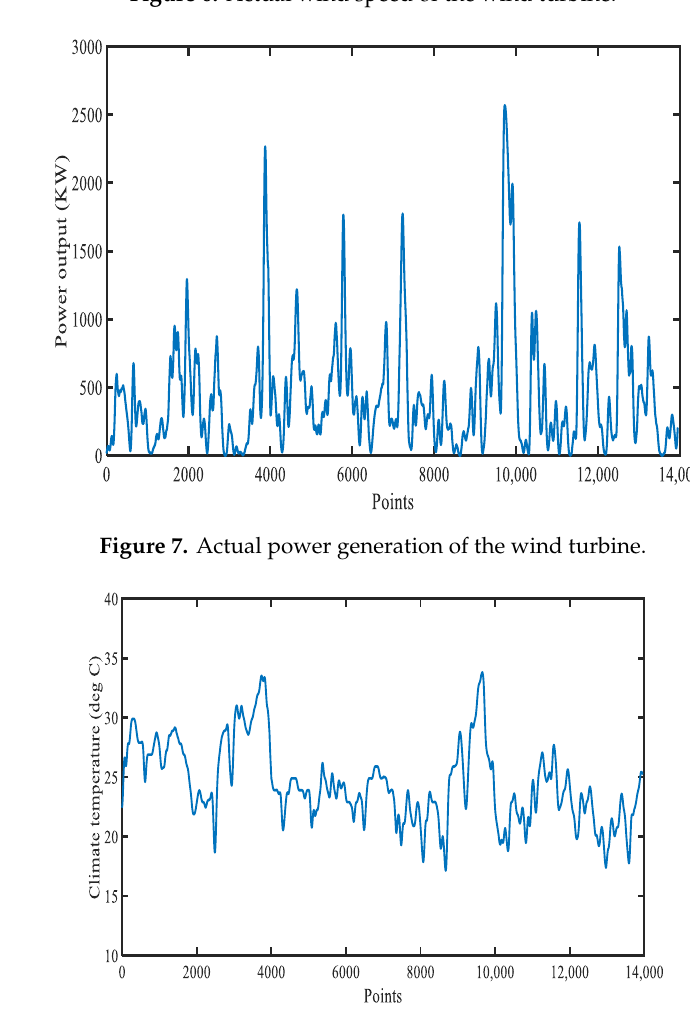
Figure 8. Actual air temperature in the wind farm.